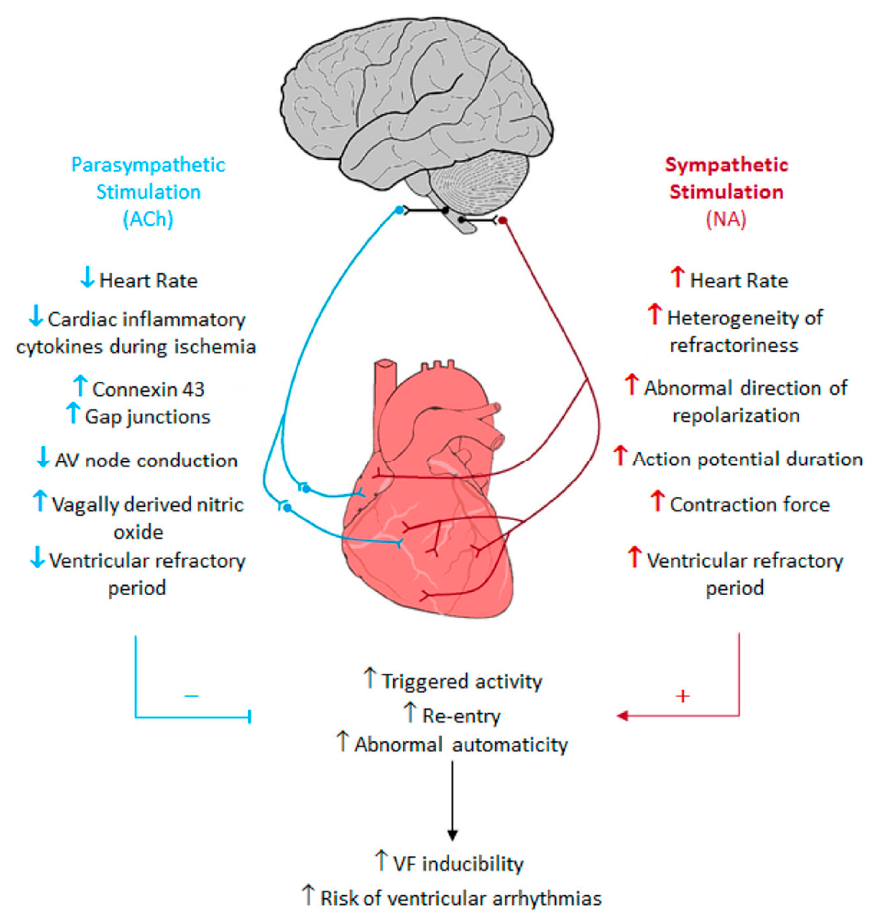
Figure 8. Cardiac arrhythmogenic effects provoked by the sympathetic and parasympathetic nervous systems [126]. Blue = parasympathetic nervous system. Red = sympathetic nervous system. Black = Connections between the brain and the parasympathetic and sympathetic nervous systems. Up arrows = increase. Down arrows = decrease. Red line and + = provoke these events. Blue line and − = inhibits these events.